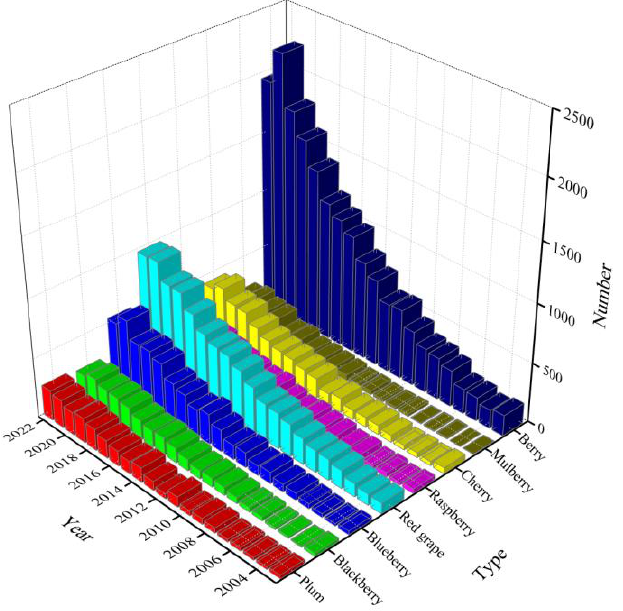
Figure 1. The statistics on the number of berry articles in Elsevier journals (2003 – 2022).